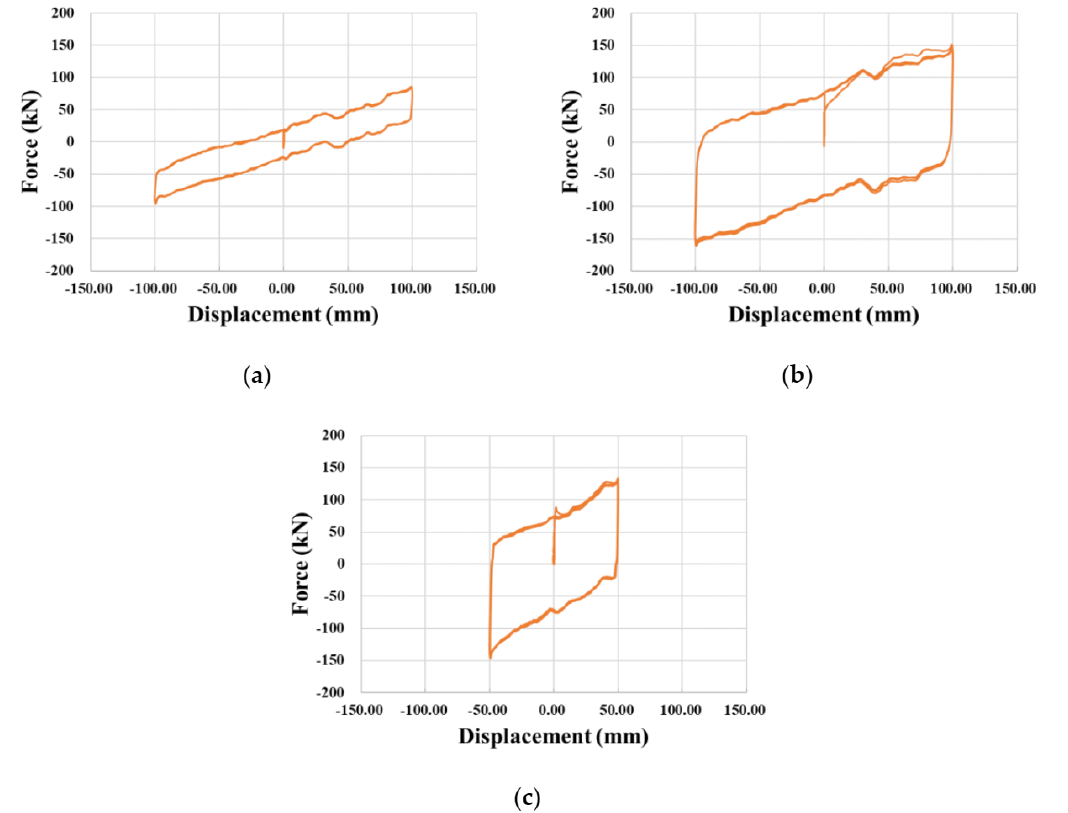
Figure 9. Measured shear force–displacement curves: ( a ) NRB; ( b ) LRB; ( c )